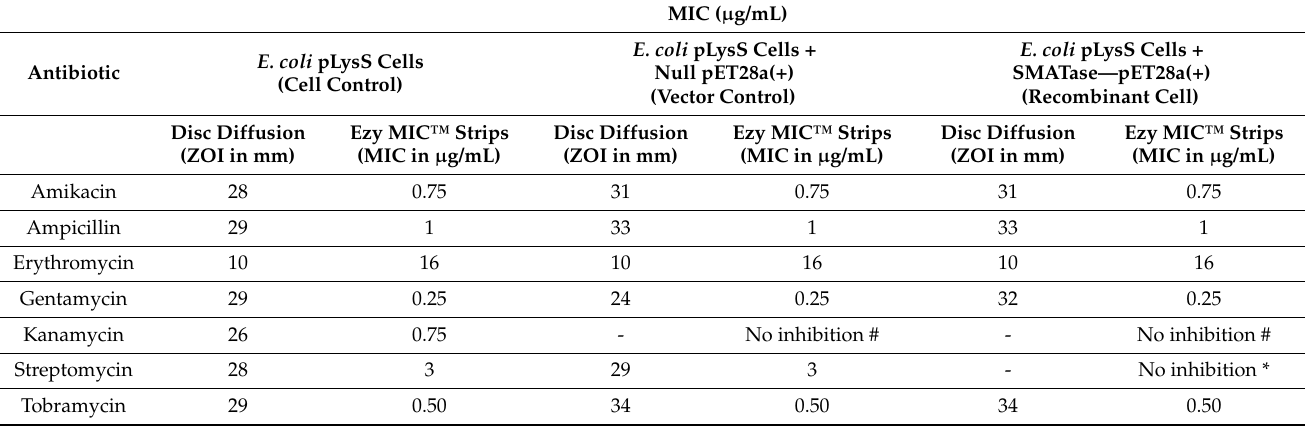
Table 2. Antibiotic susceptibility and minimal inhibitory concentration (MIC) tests: seven antibiotics in discs and Ezy MIC™ strips were tested against the cell control, vector control, and recombinant cell. Cell control (CC), empty E. coli pLysS cell; vector control (VC), E. coli pLysS cell with null pET28a vector; recombinant cell (SM), E. coli pLysS cell bearing recombinant vector expressing SMATase protein. Tested against the empty E. coli pLysS cell (cell control), E. coli pLysS cells bearing empty pET28a(+) vector (vector control) and recombinant E. coli pLysS cell bearing target gene expressing SMATase (recombinant